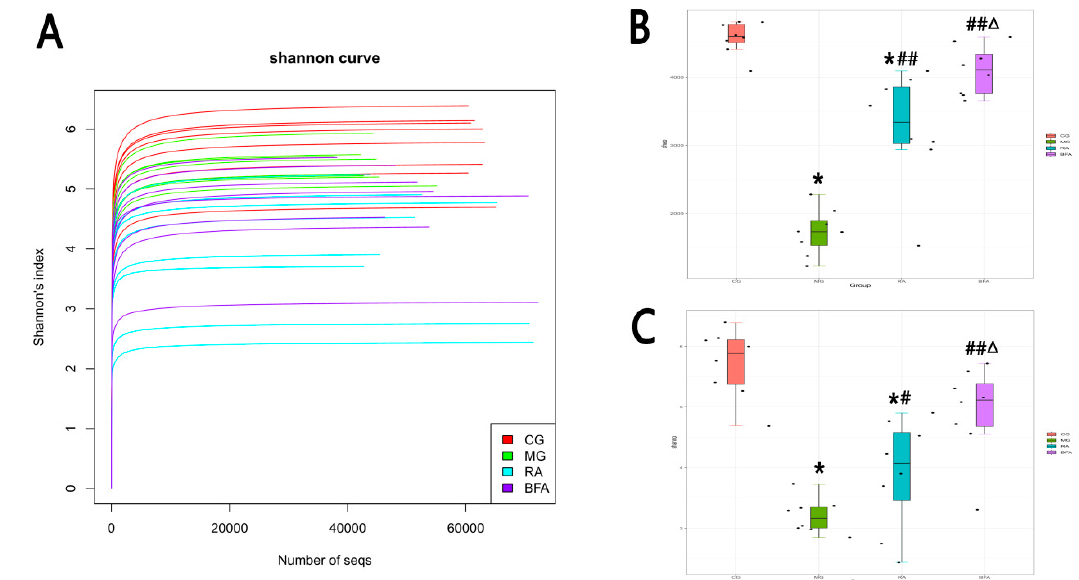
Figure 3. Comparison of alpha diversity of intestinal microbiota among diverse groups: ( A ) Shannon rarefaction curve of each group; ( B ) Chao diversity index of each group; (C ) Shannon diversity index of each group. Diversity index values are presented as box-plots, of which the black spots are the individual data points of each group ( n = 8). Differences were assessed by ANOVA. * P < 0.01 when compared with CG; # P < 0.05, ## P < 0.01 when compared with MG; △ P < 0.05 when compared with RA.